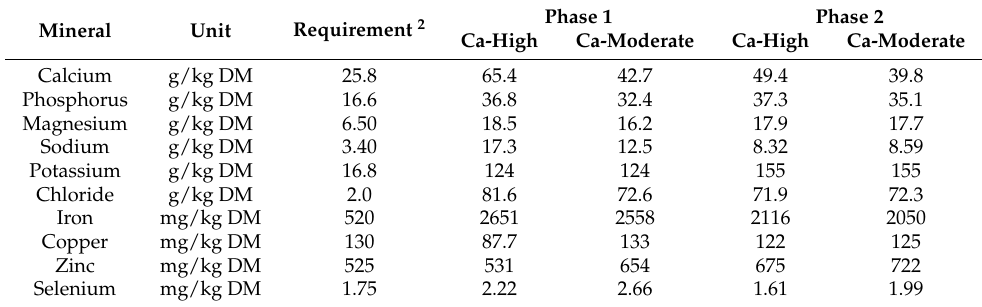
Table 3. Mineral supply 1 per stallion per day in the two experimental phases, categorised by group compared to requirements 2 .